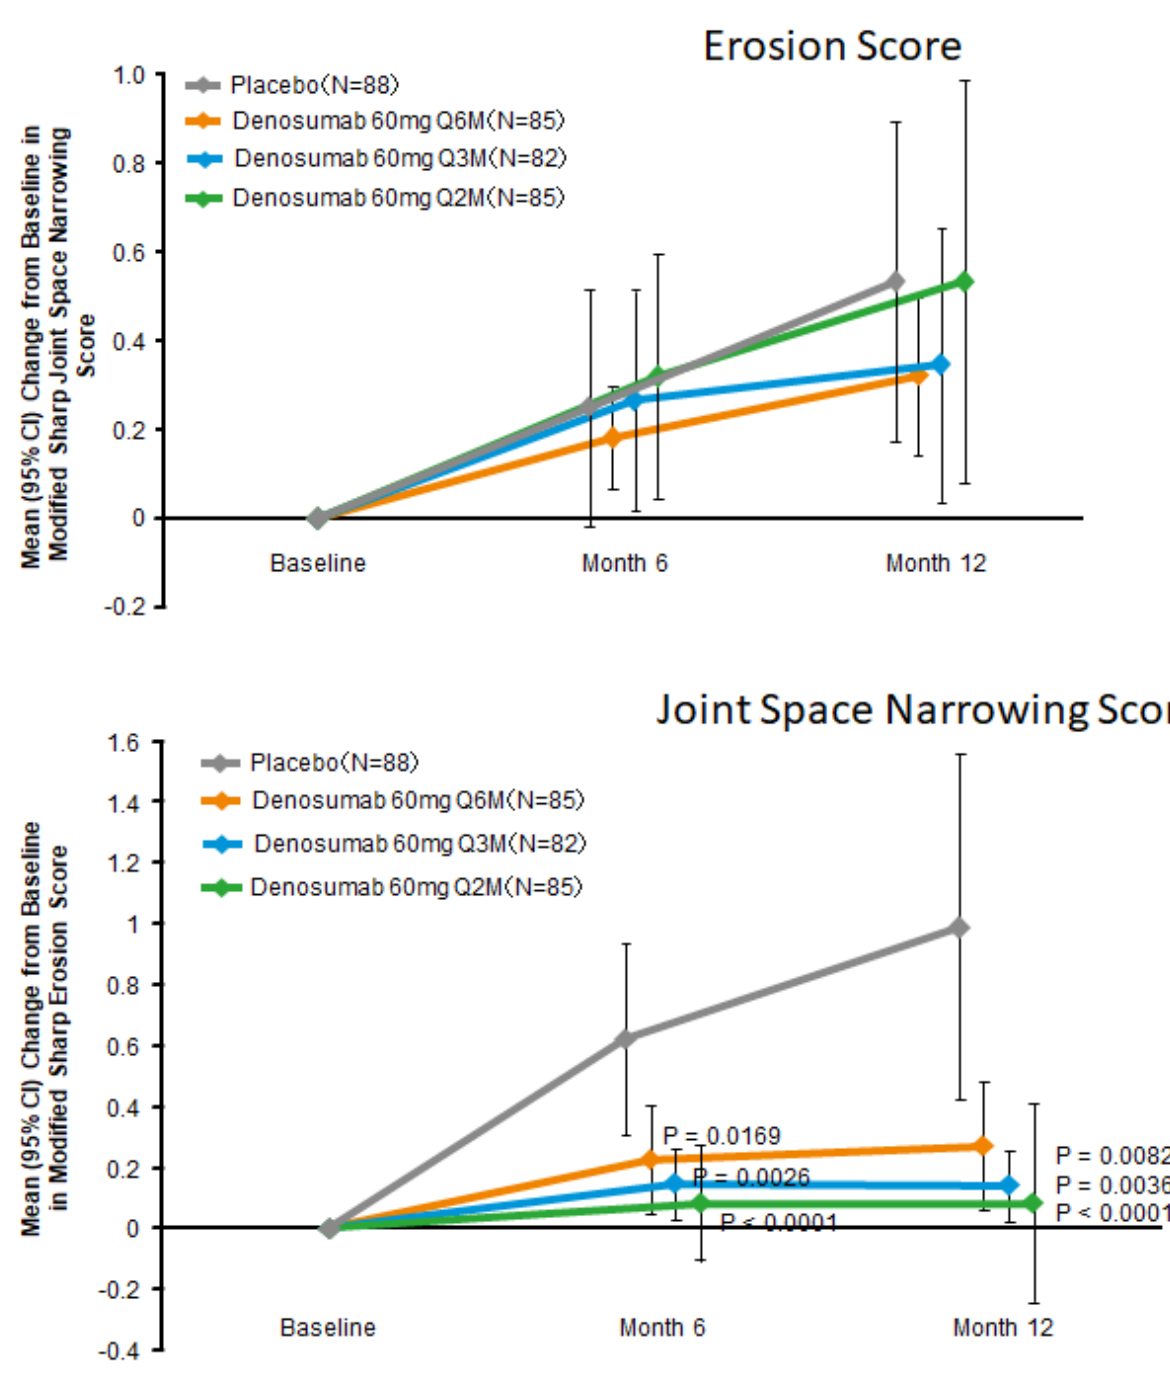
Figure 2. Denosumab significantly suppresses the bone erosion score but has no effect on the joint-space narrowing score determined by modified Sharp scores. ( a ) Modified Sharp erosion score. ( b ) Modified Sharp joint-space narrowing score. CI, confidence interval; Q2M, every 2 months; Q3M, every 3 months; Q6M, every 6 months. Modified from a figure in an article by Takeuchi et al. 30